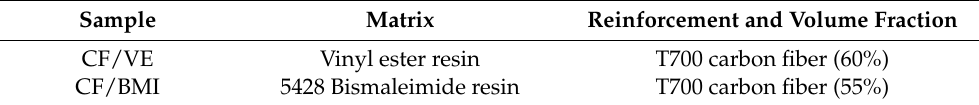
Table 1. The composition of the carbon fiber reinforced composite materials.